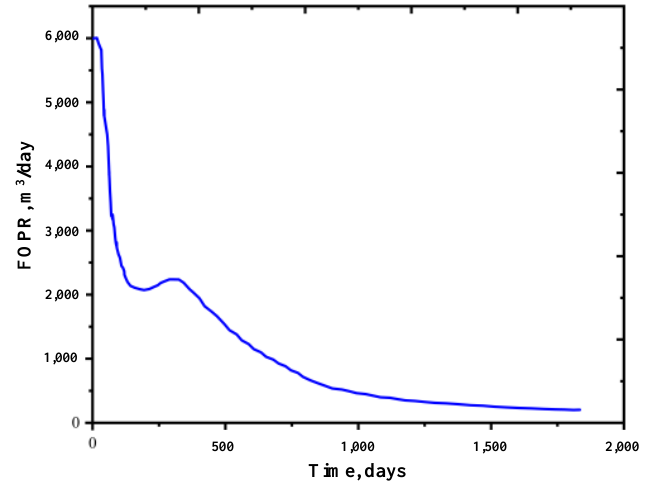
Figure 7. Field oil production rate for horizontal wells.